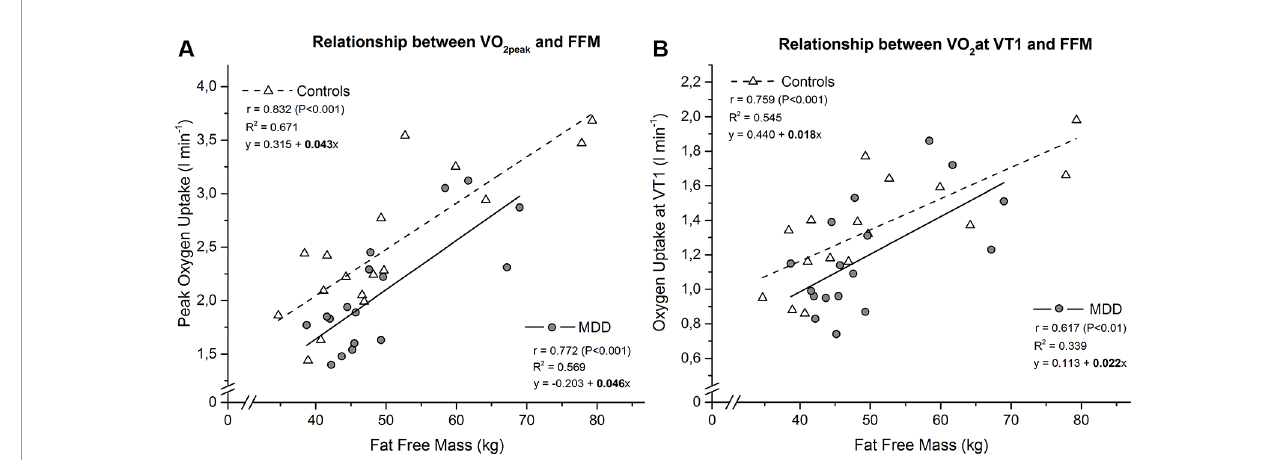
slope coef fi cients for controls (b = 0.043 for _ VO 2peak and b = 0.018 for _ VO 2VT1 ) and MDD (b = 0.046 for _ VO 2peak and b = 0.022 for _ VO 2VT1 ) were not signi fi cant different between groups (p = 0.832 for _ VO 2peak and p = 0.642 for _ VO 2VT1 ). Subsequent comparison of the intercept terms for controls (a = 0.315 for _ VO 2peak